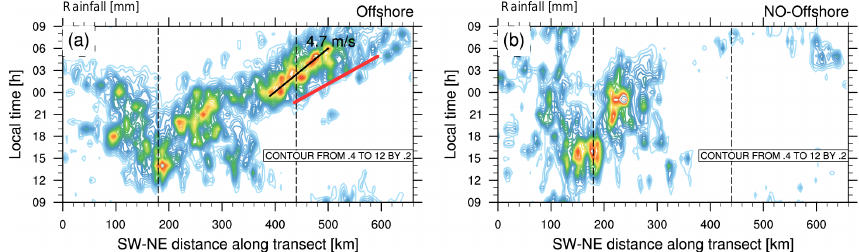
Figure 6. Composite diurnal cycle in local time (LT) in simulated (a) offshore and (b) no-offshore days, as averaged across the line sections seen in Fig. 1a. The black line represents the estimated phase speed of the peak rain signal across the northern coast, while the red line denotes the estimated phase speed of the broader rain envelope ( ∼ 8ms − 1 ). Vertical dashed lines mark the terrain peak and the coast as in Fig. 4.